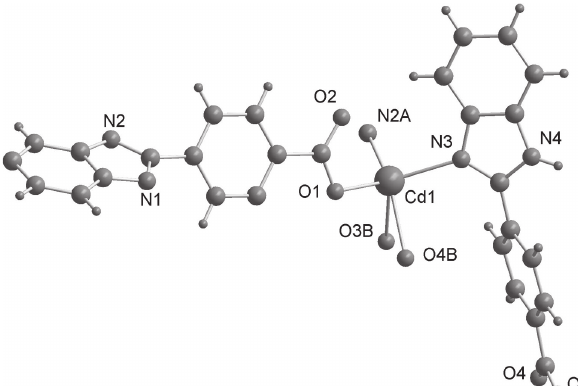
Table 2: Fractional atomic coordinates and isotropic or